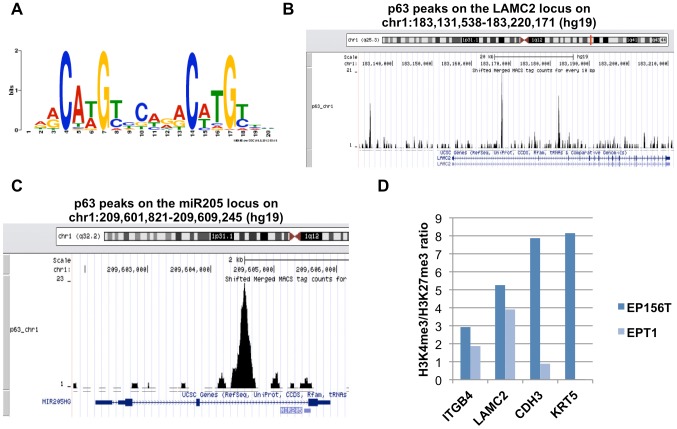
p63 ChIP-seq analysis and epigenetic pattern in EPT1 cells.(A) p63 binding consensus sequence. (B) p63 peak pattern in putative regulatory regions of LAMC2, corresponding to the p63 binding consensus sequence. (C) Peaks corresponding to p63 binding sites within the miR-205 regulatory regions. (D) H3K4me3/H3K27me3 ratio based on ChIP-chip data in EP156T and EPT1 cells.